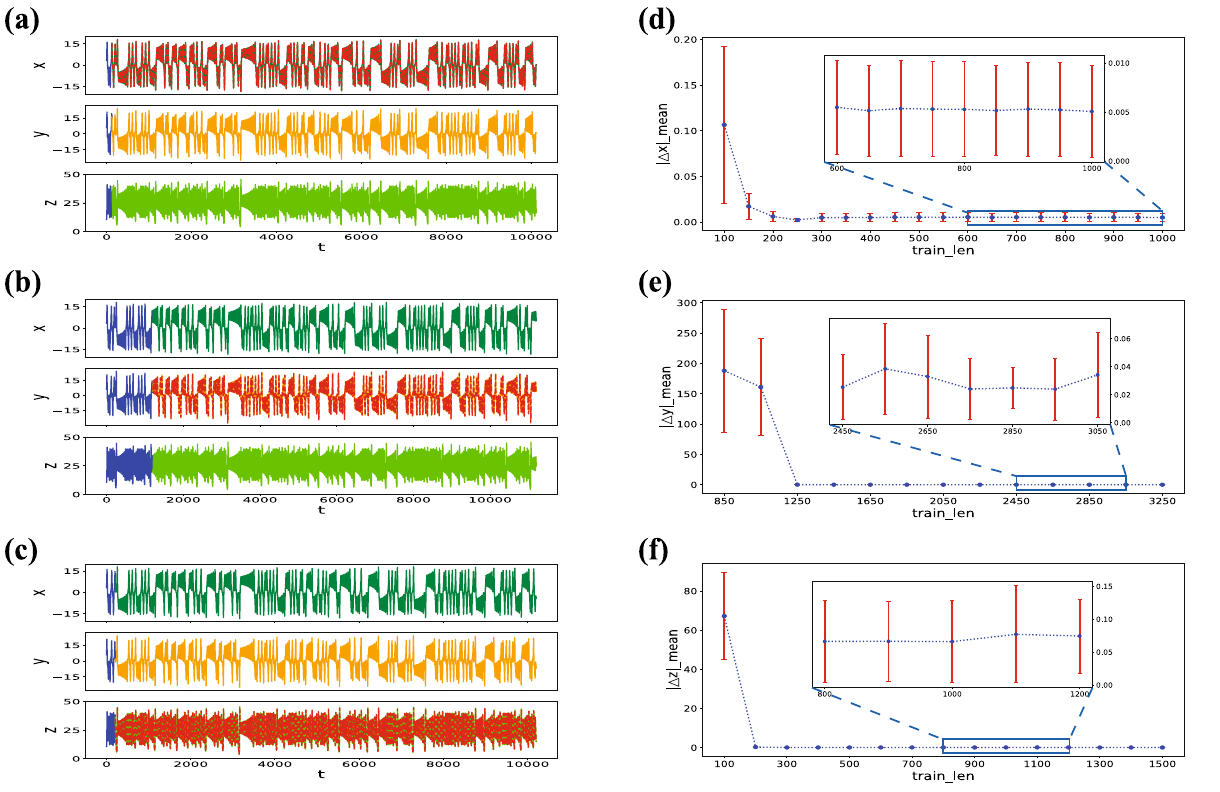
Figure 3. ( a – c ) The sequence diagram in the yz − x mode, xz − y mode and xy − z mode, the blue solid line is the training length ( T train ). The red dotted line represents the trajectories of reconstructed variables which are calculated by the “calibrated” reservoir, for T test = 10 4 . ( d – f ) Reconstruction errors of the Lorenz system variables x , y , and z in the three modes: yz − x mode, xz − y mode and xy − z mode, respectively. The blue dots represent the corresponding average values of the absolute difference between the reconstructed and actual value. The red error bars are the standard deviation values of | (cid:31) x | , | (cid:31) y | , | (cid:31) z | . The subgraphs are partially enlarged views of ( d – f ). All modes’ reconstruction error falls dramatically at initially, then it reaches a stable value as training length increases. (Without special instructions, the blue dots and red error bars remain the same